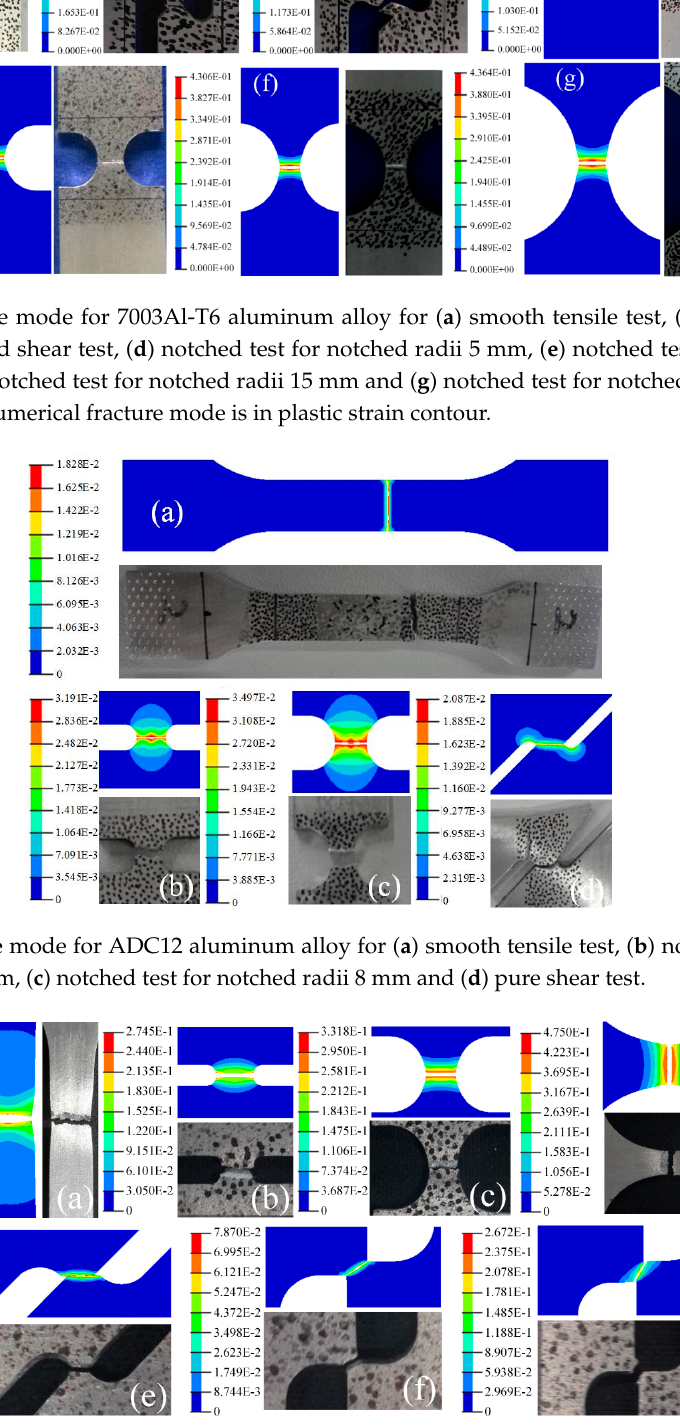
Figure 8. Fracture mode for ZK60 magnesium alloy for ( a ) smooth tensile test, ( b ) notched test for notched radii 1mm, ( c ) notched test for notched radii 5mm, ( d ) notched test for notched radii 10mm, ( e ) pure shear test, ( f ) shear and tensile test at shear angle 30° and ( g ) shear and tensile test at shear angle 60°.